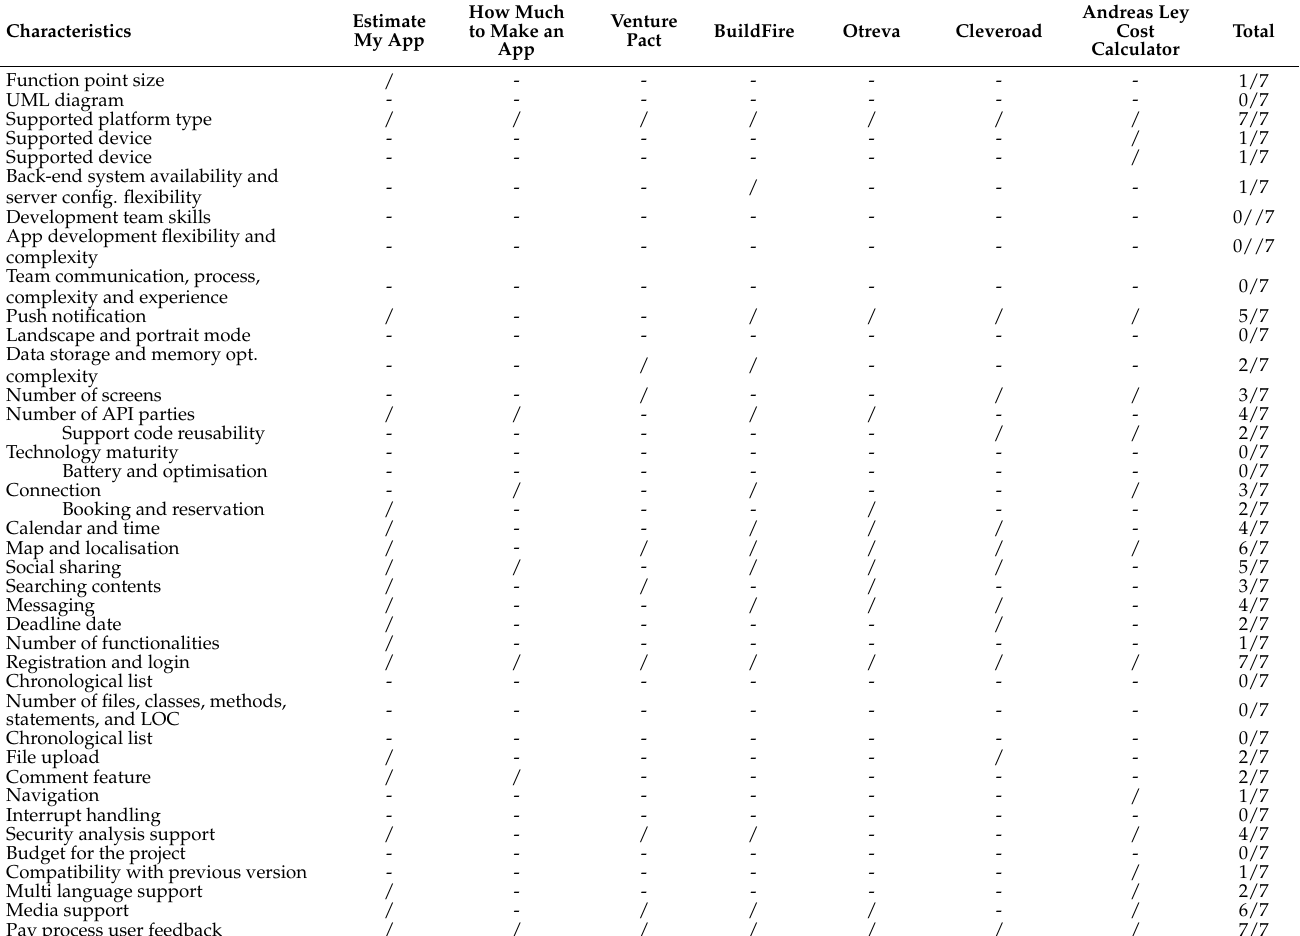
Table 1. Comparison of cost drivers towards seven estimation